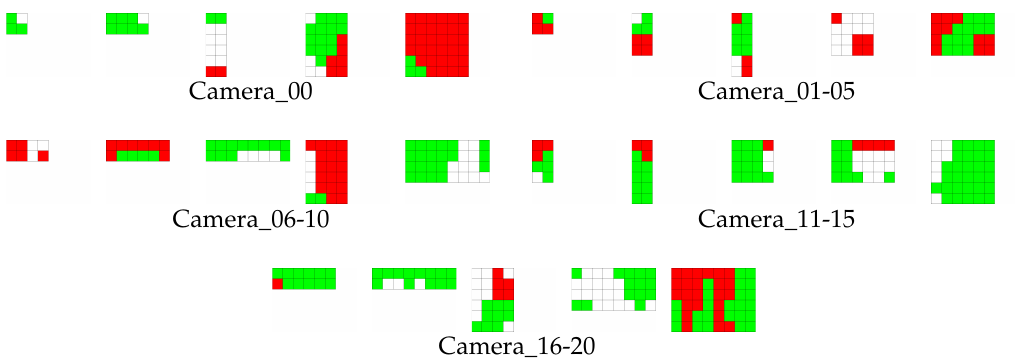
Figure 13. Examples of templates used to construct a classifier for